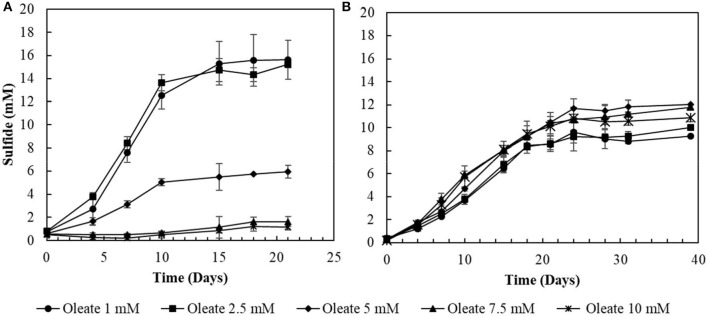
Toxicity profiles of oleate to (A) elemental sulfur- and (B) thiosulfate-reducing cultures. Measurements of biological triplicates were averaged, and the standard deviation is shown.